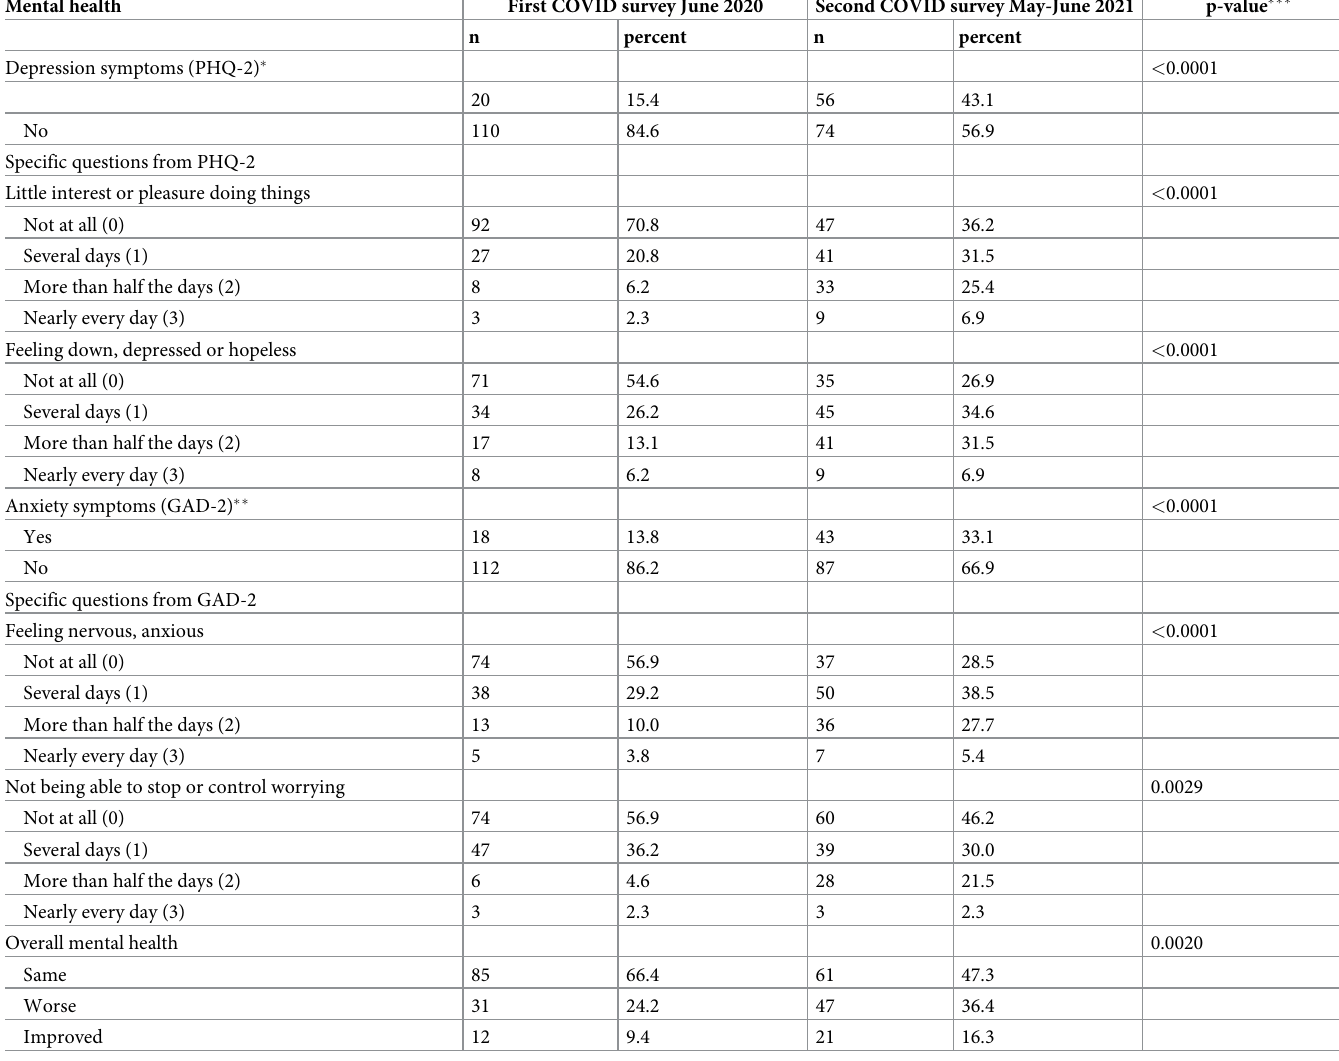
Table 3. 2020 and 2021 COVID-19 Surveys of mental health symptoms, (n = 130). Mental